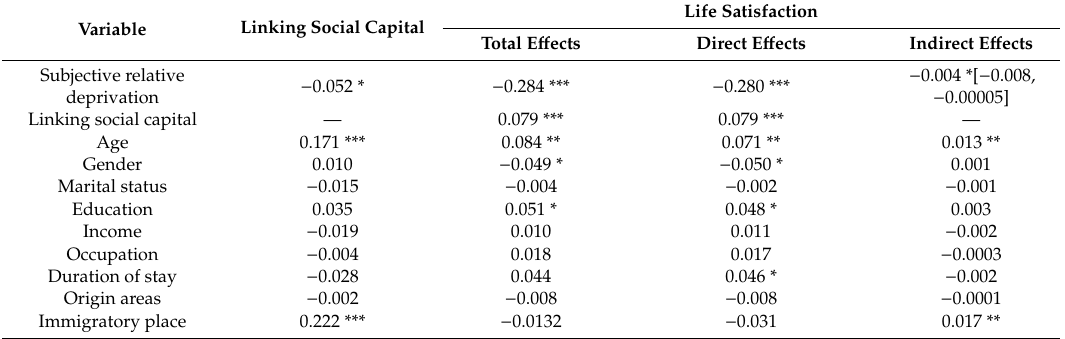
Table 3. The e ff ects of subjective relative deprivation on life satisfaction through linking social